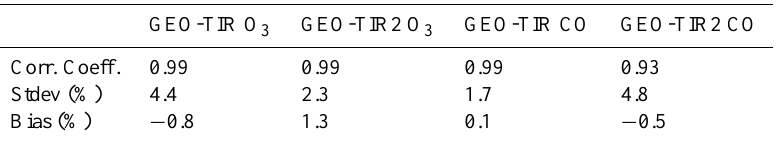
Table 2. Correlation coefficient, standard deviation (%) and bias (%) between observations generated with the look-up tables and observations generated with KOPRA-fit, calculated with respect to observations generated with KOPRA-fit for O 3 (1st and 2nd columns) and CO (3rd and 4th columns) and for the configurations of GEO-TIR (2nd and 4 thcolumns) and GEO-TIR2 (1st and 3rd columns). These statistics have been calculated for data with altitudes between the surface and